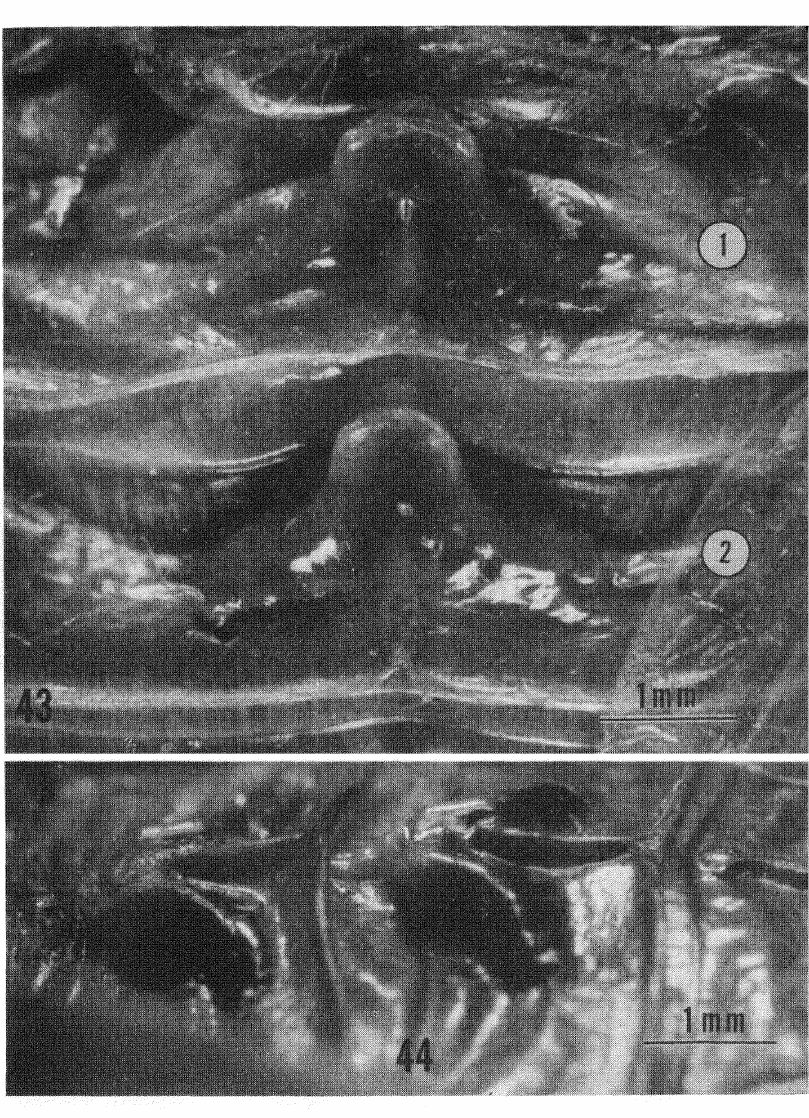
Figs. 43-44. Poeciloderrhis atrieent, ris. Tergal glands on segments and 2 (circled numbers). (9, BMNH). Dorsal (Fig. 43) and lateral (Fig. 44) views; genitalia in Figs. 34-36). (det.